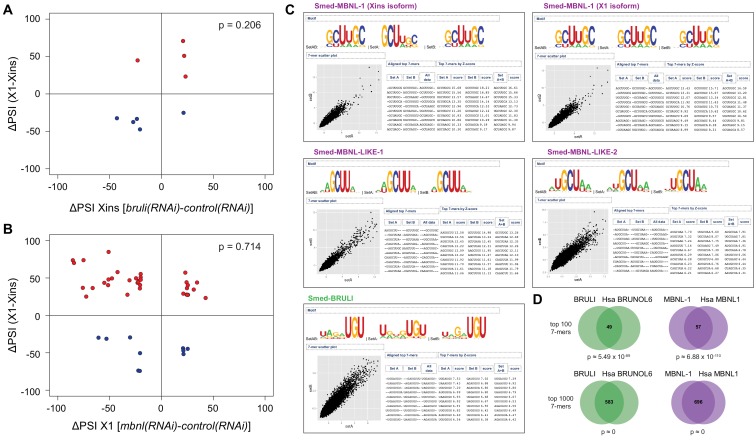
bruli and mbnl antagonistically regulate neoblast-specific AS.(A-B) bruli and mbnl have a minor impact on neoblast-differential AS events in Xins and X1, respectively: (A) Lack of association (p = 0.206, one-sided binomial test) between differences in inclusion levels (ΔPSI) of neoblast-differential AS events in X1 versus Xins fractions, and differences in bruli and control RNAi treated Xins fractions. (B) Lack of association (p = 0.714, one-sided binomial test) between differences in inclusion levels (ΔPSI) of neoblast-differential AS events in X1 versus Xins fractions, and differences in mbnl and control RNAi treated X1 fractions. (C) RNAcompete-derived motifs for BRULI and MBNL proteins. Top-scoring RNA-binding 7mers and corresponding logos identified by RNAcompete analysis are shown for MBNL-1 (excluding a neoblast-differential exon; Xins isoform), MBNL-1 (including a neoblast-differential exon; X1 isoform), MBNL-LIKE-1, MBNL-LIKE-2, and BRULI. Scatterplots show the correlation between 7-mers Z-scores derived from microarray data splits, SetA and SetB. Logos are created after aligning the top 10 highest scoring 7-mers. Both isoforms of MBNL-1 display similar binding preferences. RNAcompete retrieved simpler 4-mer or 3-mer containing GCU motifs for MBNL-LIKE-1 and MBNL-LIKE-2, which contain only one pair of zinc fingers. (D) Conserved binding specificities for planarian and human CELF and MBNL splicing factors: Venn diagrams showing the overlap of RNA-compete 7-mers, comparing the top 100 (top) and the top 1000 (bottom) 7-mers of planarian and human proteins. P-values correspond to hypergeometric tests.